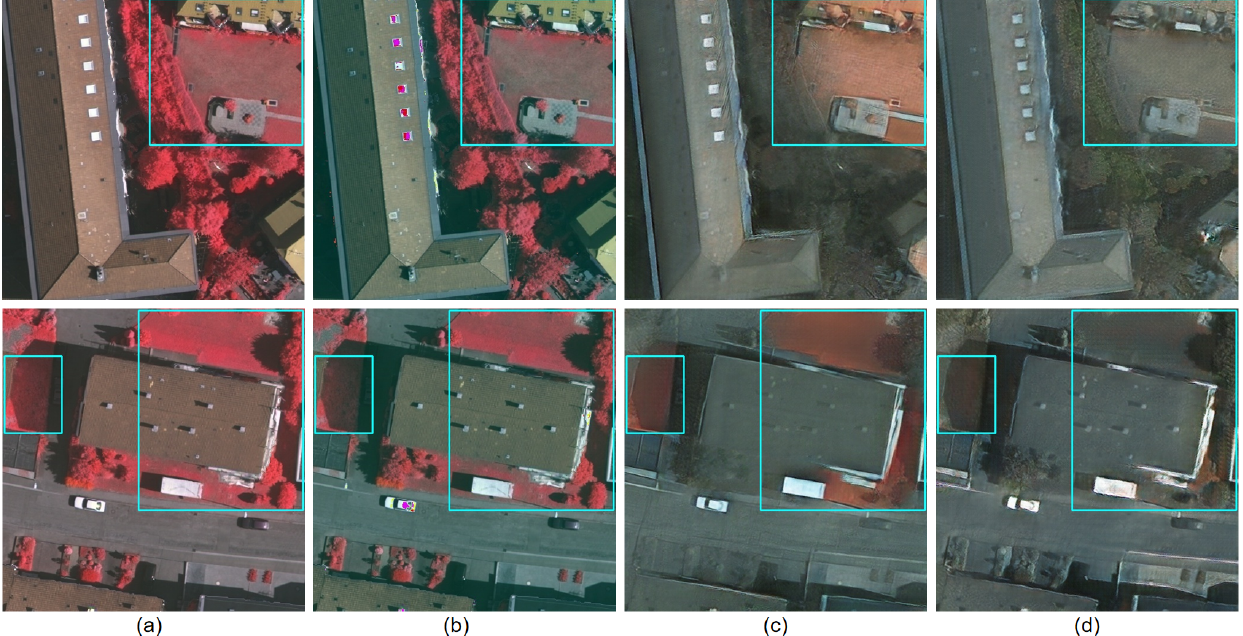
Figure 16. Vaihingen to Potsdam: Original Vaihingen images and the transformed images which are used to train the classifier for Potsdam images. ( a ) Vaihingen images. ( b ) Color matching. ( c ) CycleGAN. ( d ) BiFDANet